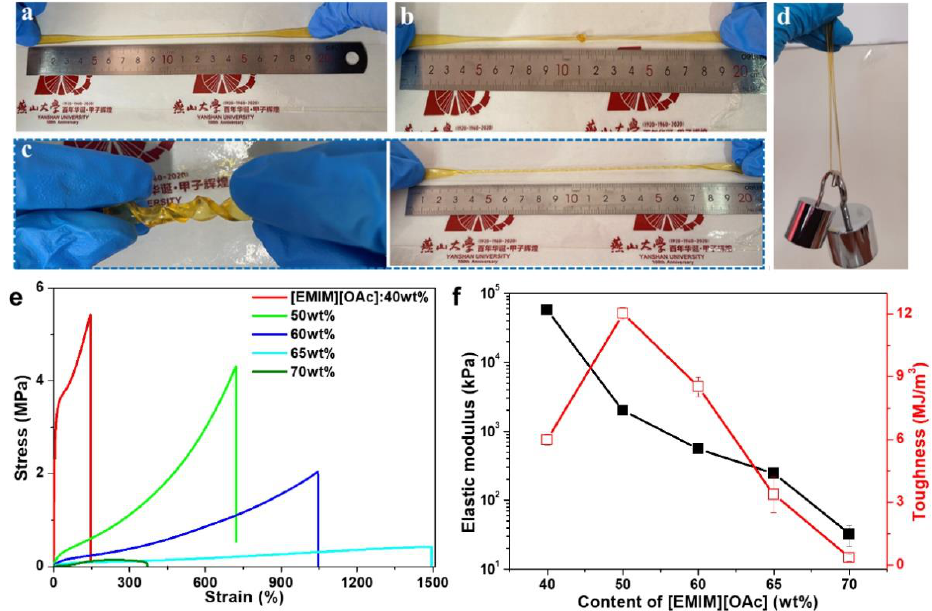
Figure 4. Excellent mechanical properties of the CS/PAA DN ionogel: tensile ( a ), knotted tensile ( b ), twisted tensile ( c ) and bearing a weight of 700 g with no damage ( d ); tensile performance of the ionogels with different contents of ionic liquid ( e ) and the corresponding elastic modulus (solid) and toughness value (open) ( f ).